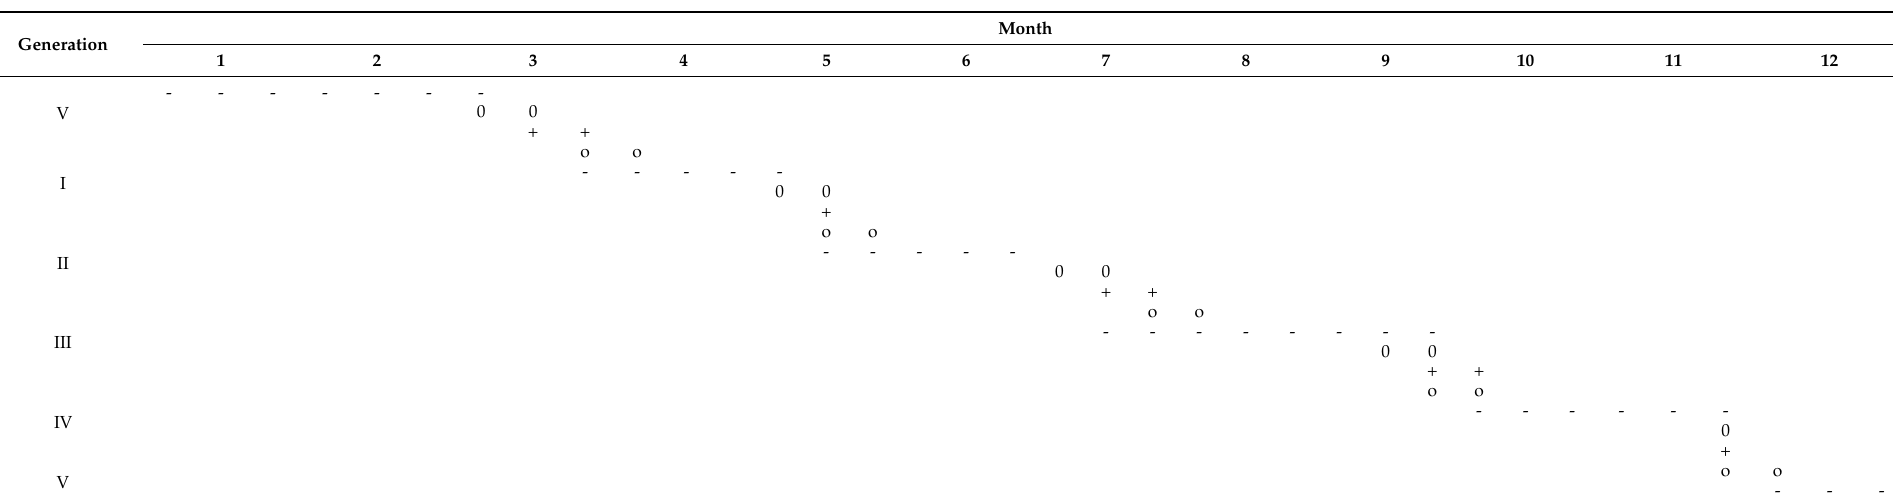
Table 2. Life cycles and emergence times of Dasychira axutha in the Northeast region of